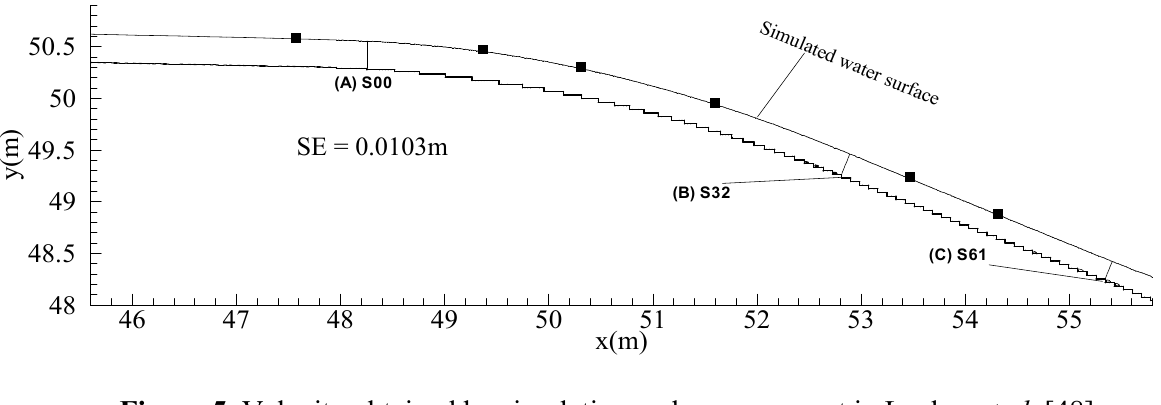
Figure 5. Velocity obtained by simulation and measurement in Lueker et al. [48].